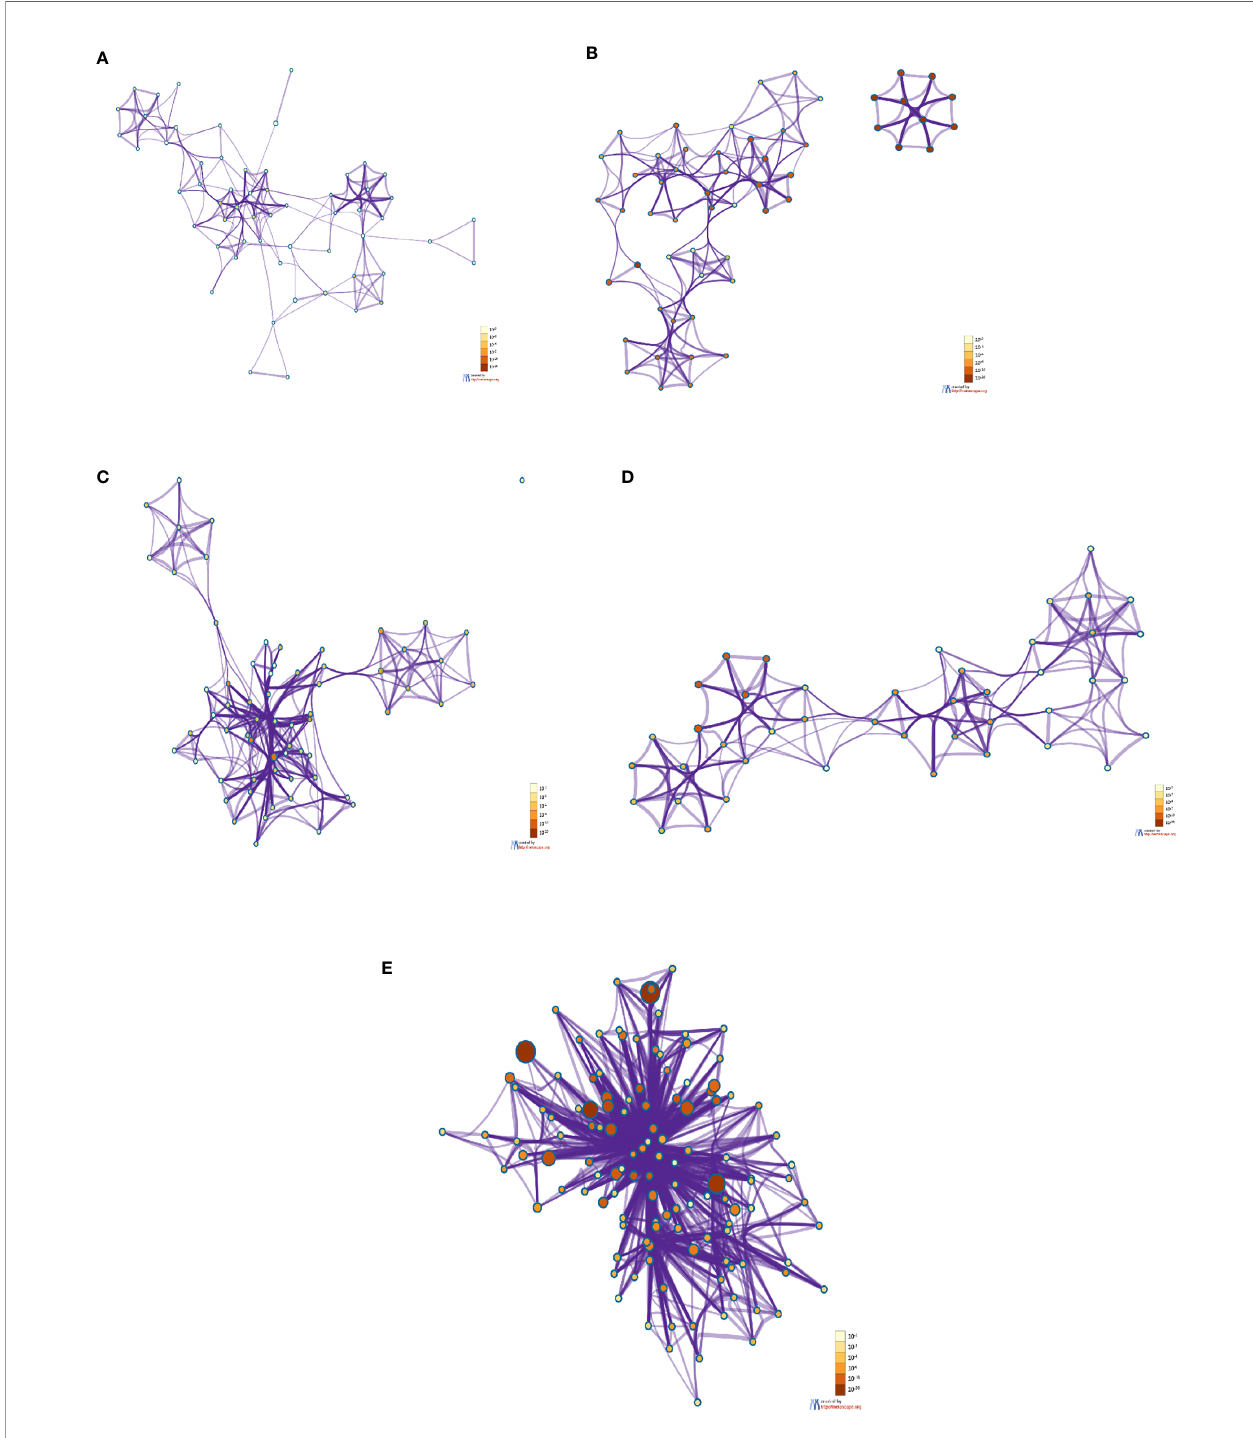
FIGURE 8 | The enrichment cluster analysis of the PPI network using protein-coding DEGs from our study and other studies. (A) The enrichment cluster analysis of the PPI network with signi fi cant protein-coding DEGs in our research. (B) The enrichment cluster analysis of the PPI network from Xiong et al. study where the samples were the bronchoalveolar lavage fl uid. (C) The enrichment cluster analysis of the PPI network with the Xiong et al. study ’ s top-ranked genes from the PBMC samples. (D) The enrichment cluster analysis of the PPI network with data from the Ziegler et al. study where the samples were collected from the lung lobe, nasal polyps, ethmoid sinus surgical tissue, and ileum. (E) The enrichment cluster analysis of the PPI network with the top-ranked protein-coding genes of the Jain et al. study that used nasopharyngeal swab